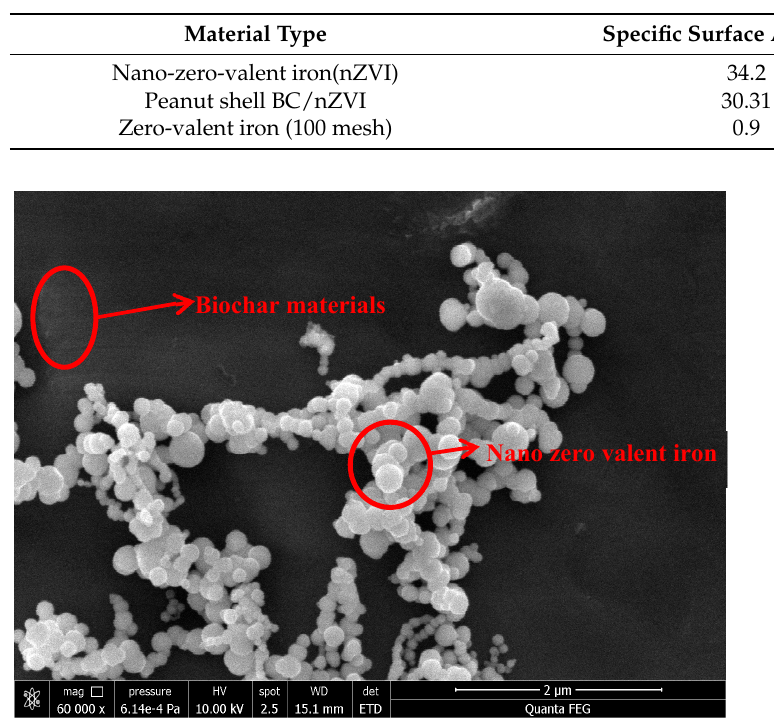
Figure 1. Scanning electron micrographs of different BC/nZVI.